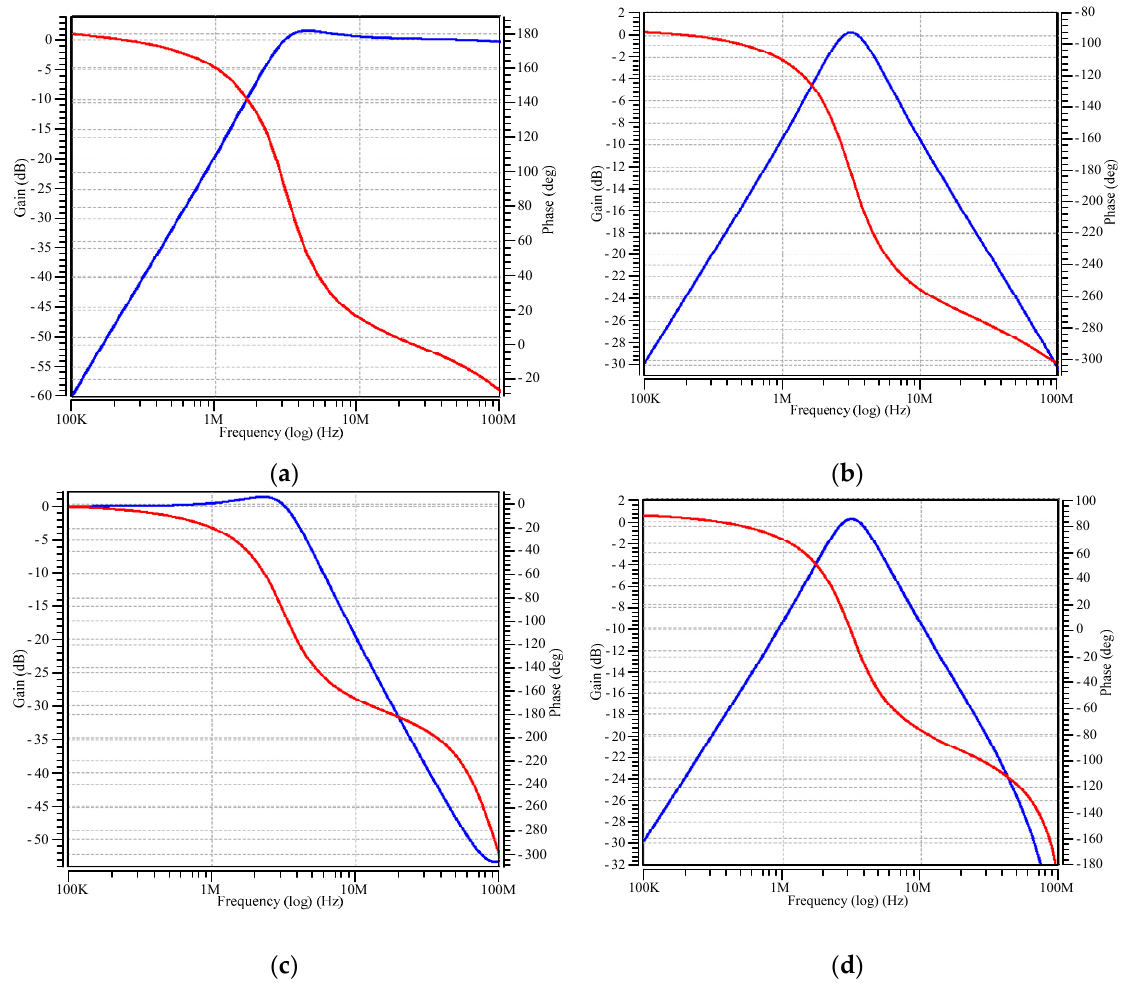
Figure 16. The CM post-layout gain (blue line) and phase (red line) simulation responses ( a ) highpass filter (I o1 /I in ); ( b ) bandpass filter (I o2 /I in ); ( c ) lowpass filter (I o3 /I in ),; and ( d ) bandpass filter (I o4 /I in ).